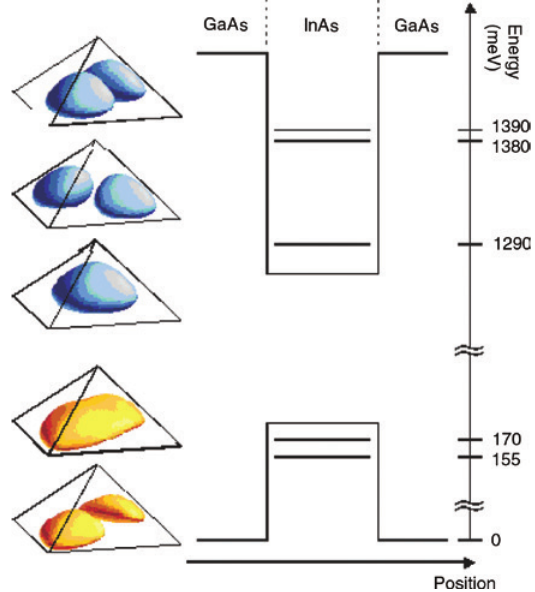
Figure 2: Wave functions and energy levels for the three lowest electron and two lowest hole eigenstates in a pyramidal InAs/GaAs